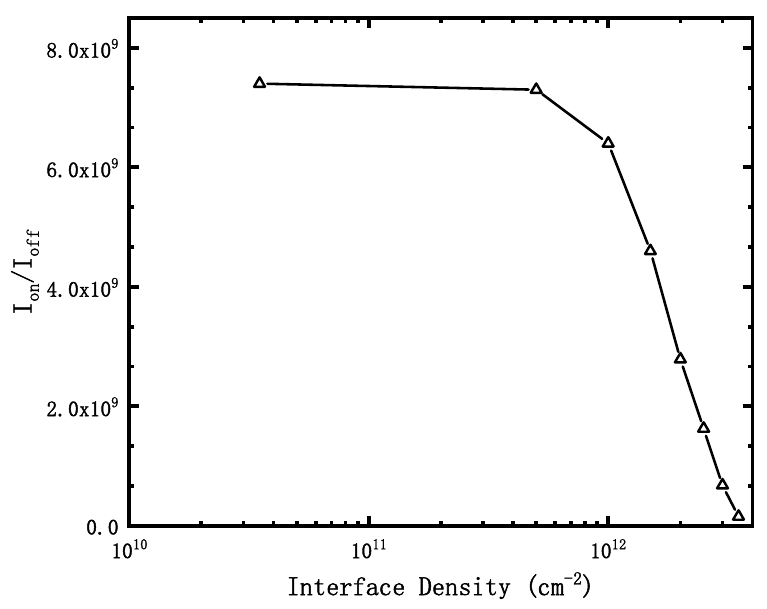
Figure 3. I on /I off with different interface density.